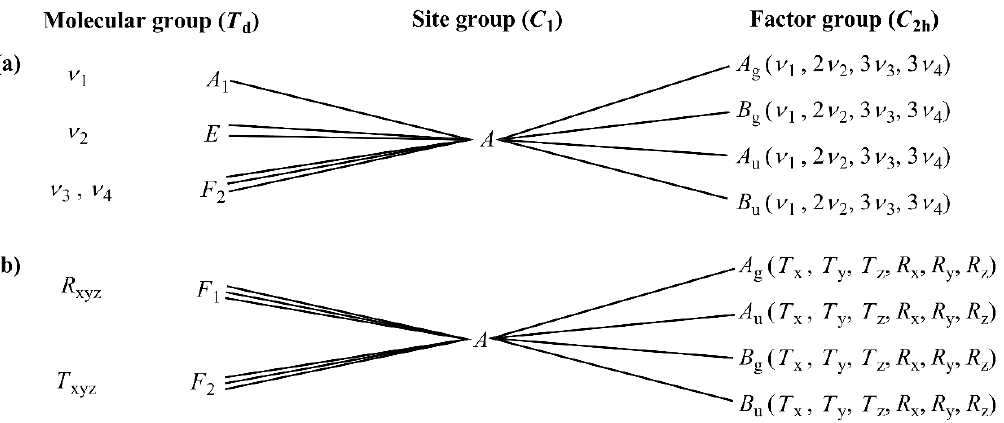
Figure 5. ( a ) Internal and ( b ) external permanganate vibrations in compound 1. ν 1 —symmetric stretch.; ν 2 —symmetric bend.; ν 3 —antisymmetric stretch; ν 4 —antisymmetric bend.